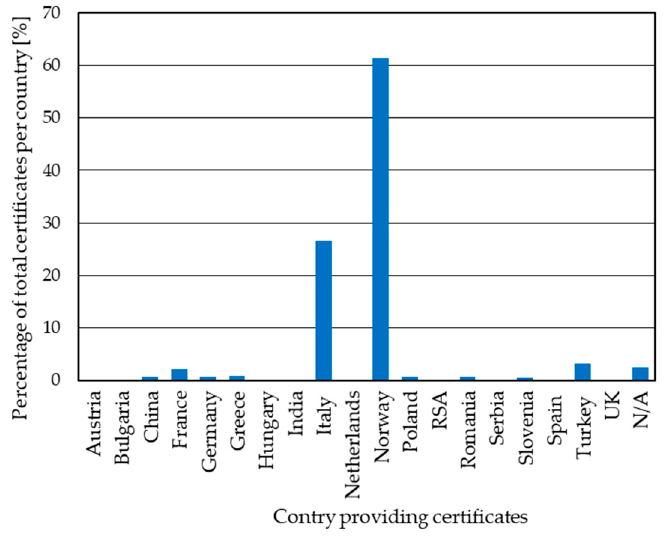
Figure 1. Distribution of obtained material test certificates (tensile test results) by country.